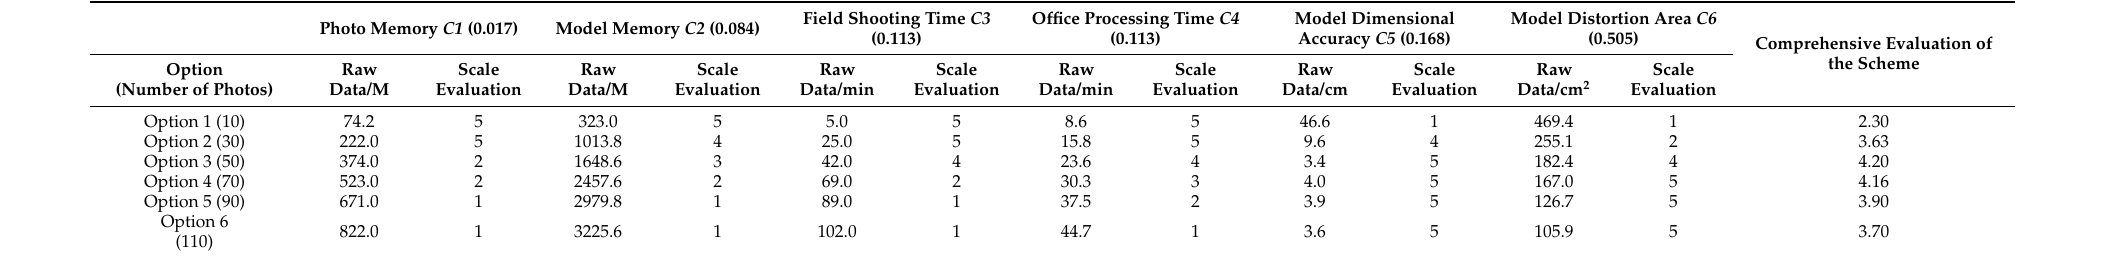
Table 6. Experimental data acquisition and scale evaluation of C